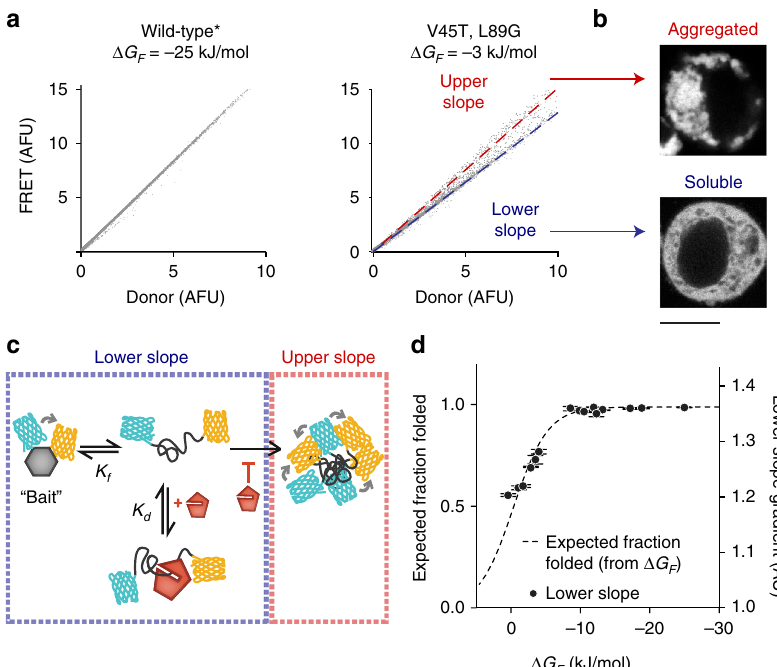
Fig. 3 Barnase foldedness and aggregation can be readily assessed by fl ow cytometry. a Flow cytometry analysis to determine FRET. Data points indicate fl uorescence signatures of individual cells for donor and FRET channels. b Representative confocal images of cells recovered by cell sorting (scale bar = 10 µ m; “ Soluble ” image scaled at 4×brightness vs. “ Aggregated ” ). c Conceptual framework for how fl ow cytometry data reports on foldedness vs. aggregation d The Lower-slope gradients of barnase mutants measured by fl ow cytometry (right axis) follows the expected relationship between stability ( Δ G F ) and fraction folded (left axis, scaled to fi t). Each data point re fl ects one barnase mutant (mean ± SD; three replicates). Note that the AFU or AU scales, while arbitrary, cannot be compared between different panels and fi gures due to changes in instrument calibration